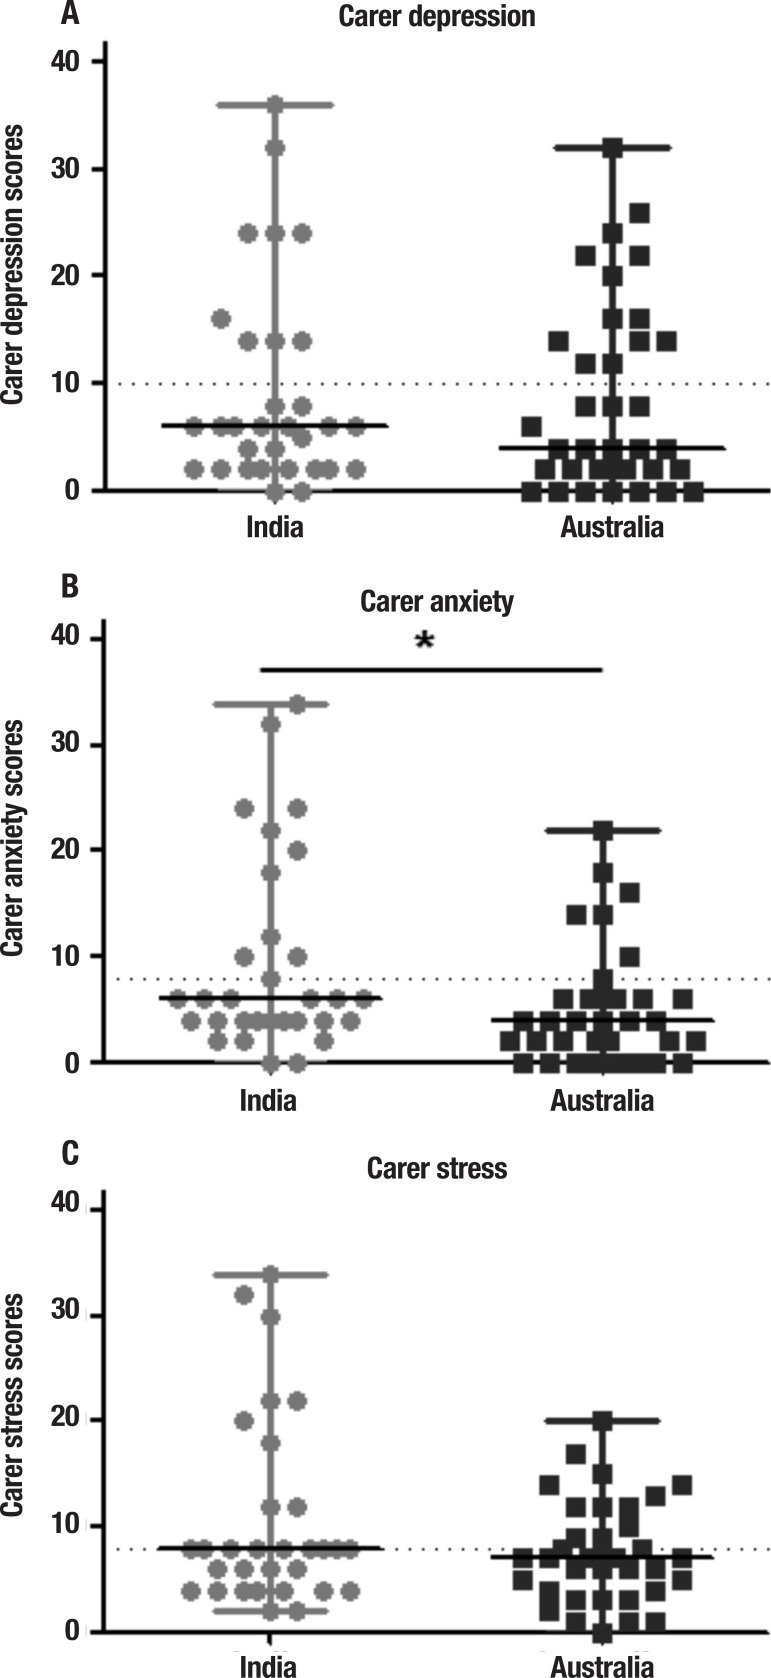
Comparison of scores on carer [A] depression, [B] anxiety and [C] stress
on the Depression, Anxiety and Stress-21, between India and Australia.
Dotted lines represent clinical cut off. Mann-Whitney tests,
p<0.05.